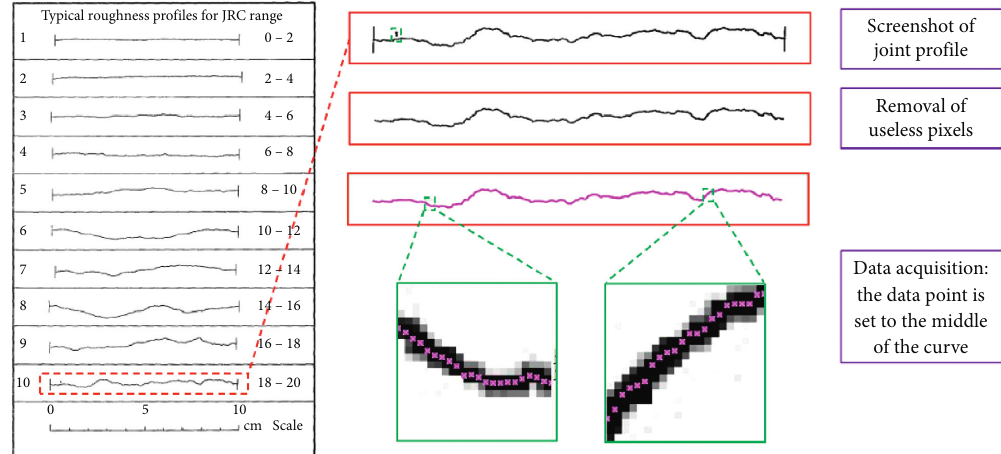
Figure 4: The diagram used to show the digitization of a joint